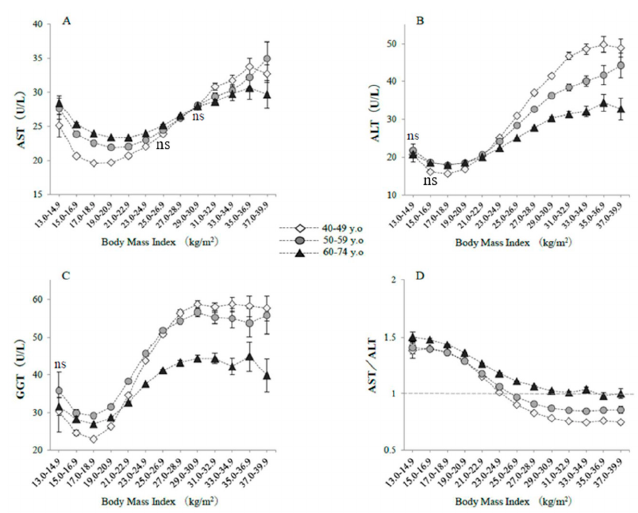
Figure 1. Raw serum enzyme activities, classified according to body mass index and age. The symbols indicate the mean values, and the vertical bars represent the 95% confidence intervals (CIs). BMI